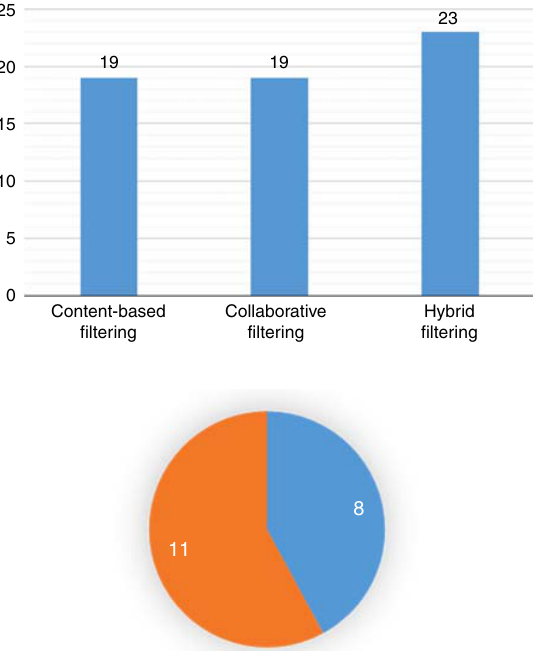
Figure 7. The distribution of the two subcategories of collaborative